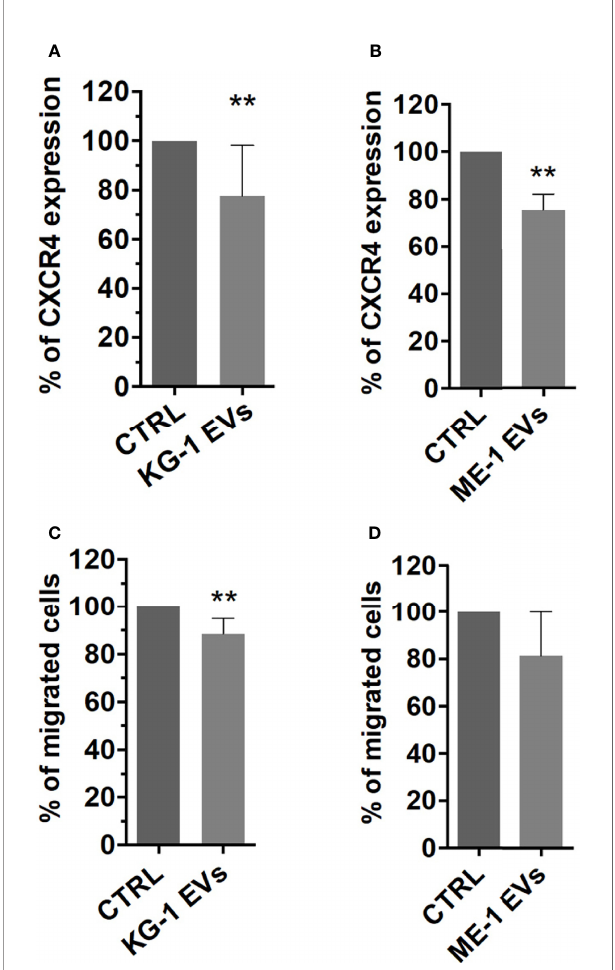
FIGURE 7 | CXCR4expressionandSDF-1mediatedmigrationinHSPCs treated withAML-EVs. PercentageofCXCR4 expressiononHSPCs treatedor notwith KG-1 (A) or ME-1EVs (B) . Percentage ofmigratedcells after treatmentofHSPCs withKG-1 (C) or ME-1 EVs (D) . The bar-graphs represent mean+ SDfrom three